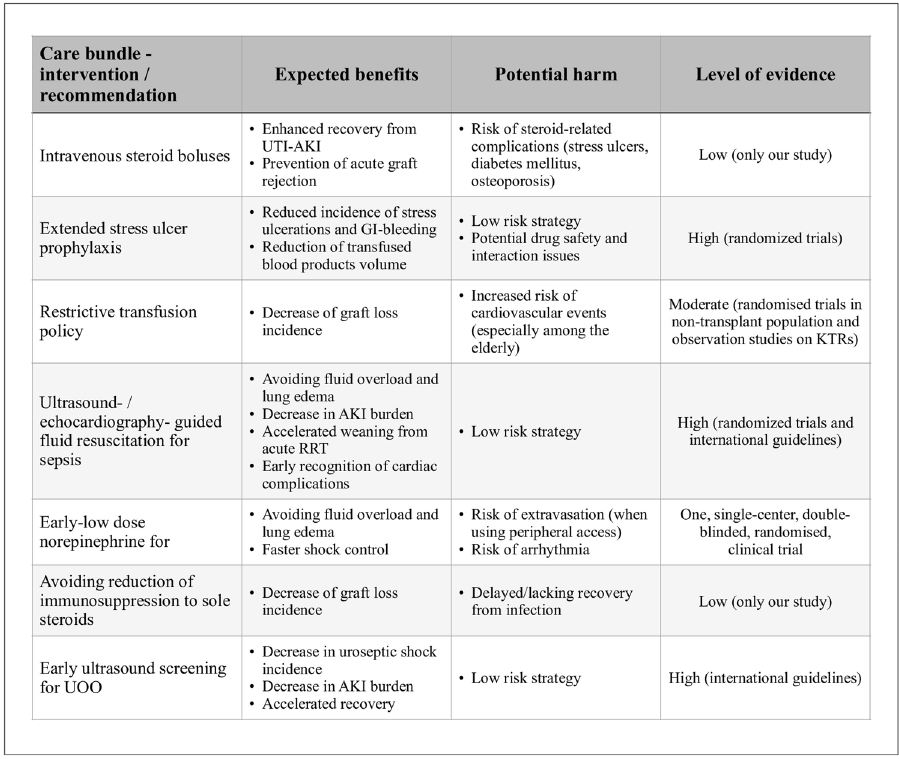
Figure 7. Summary of recommendations regarding acute care of KTRs with UTI and